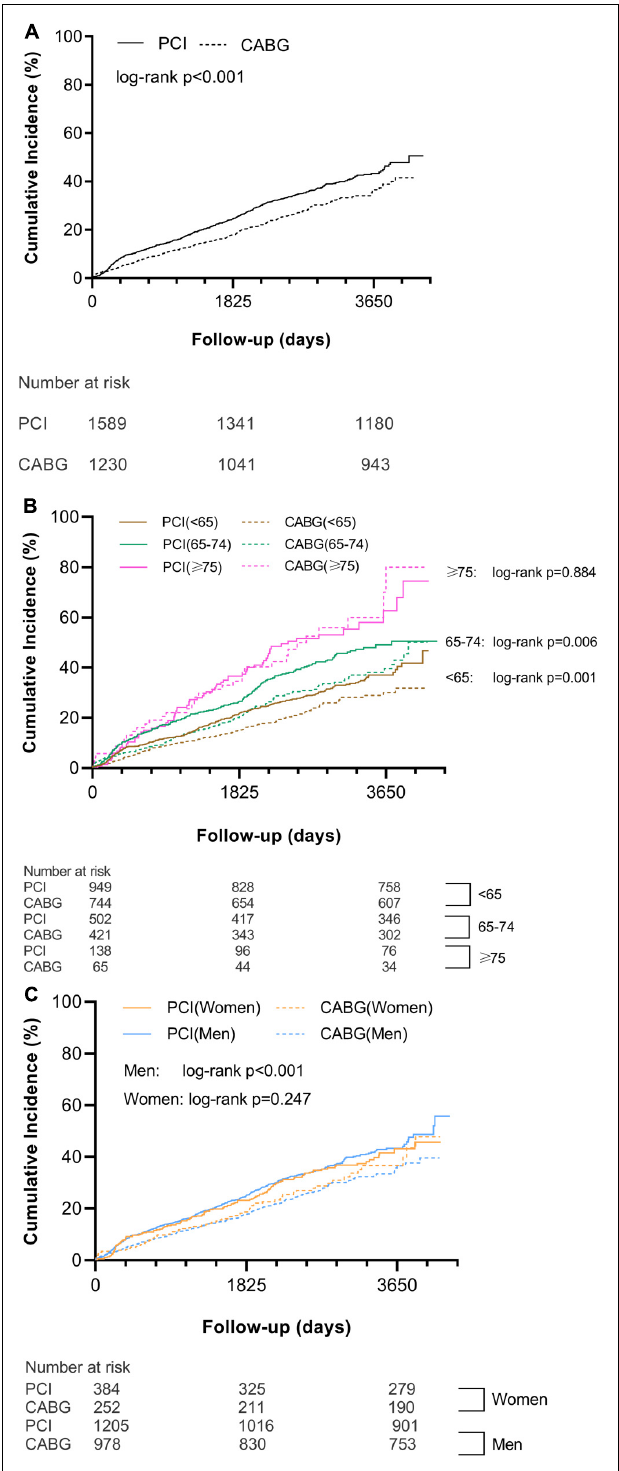
FIGURE 2 | Cumulative incidence of MACCE in all patients (A) , different age categories (B) , and different sex groups (C) . MACCE, major adverse cardiovascular and cerebrovascular event; PCI, percutaneous coronary intervention; and CABG, coronary artery bypass grafting.